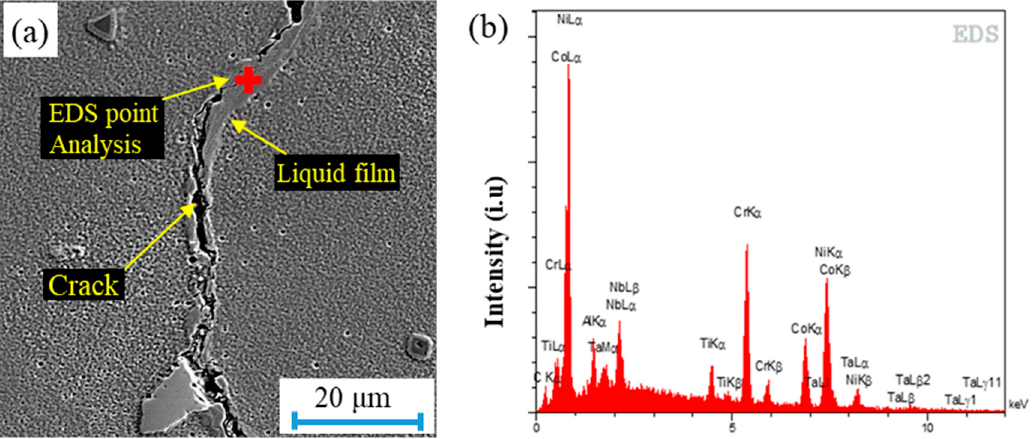
Figure 12. Elemental analysis of crack nucleation site: ( a ) SEM photo of liquid film and crack in the grain boundary and ( b ) EDS analysis of the liquid film.